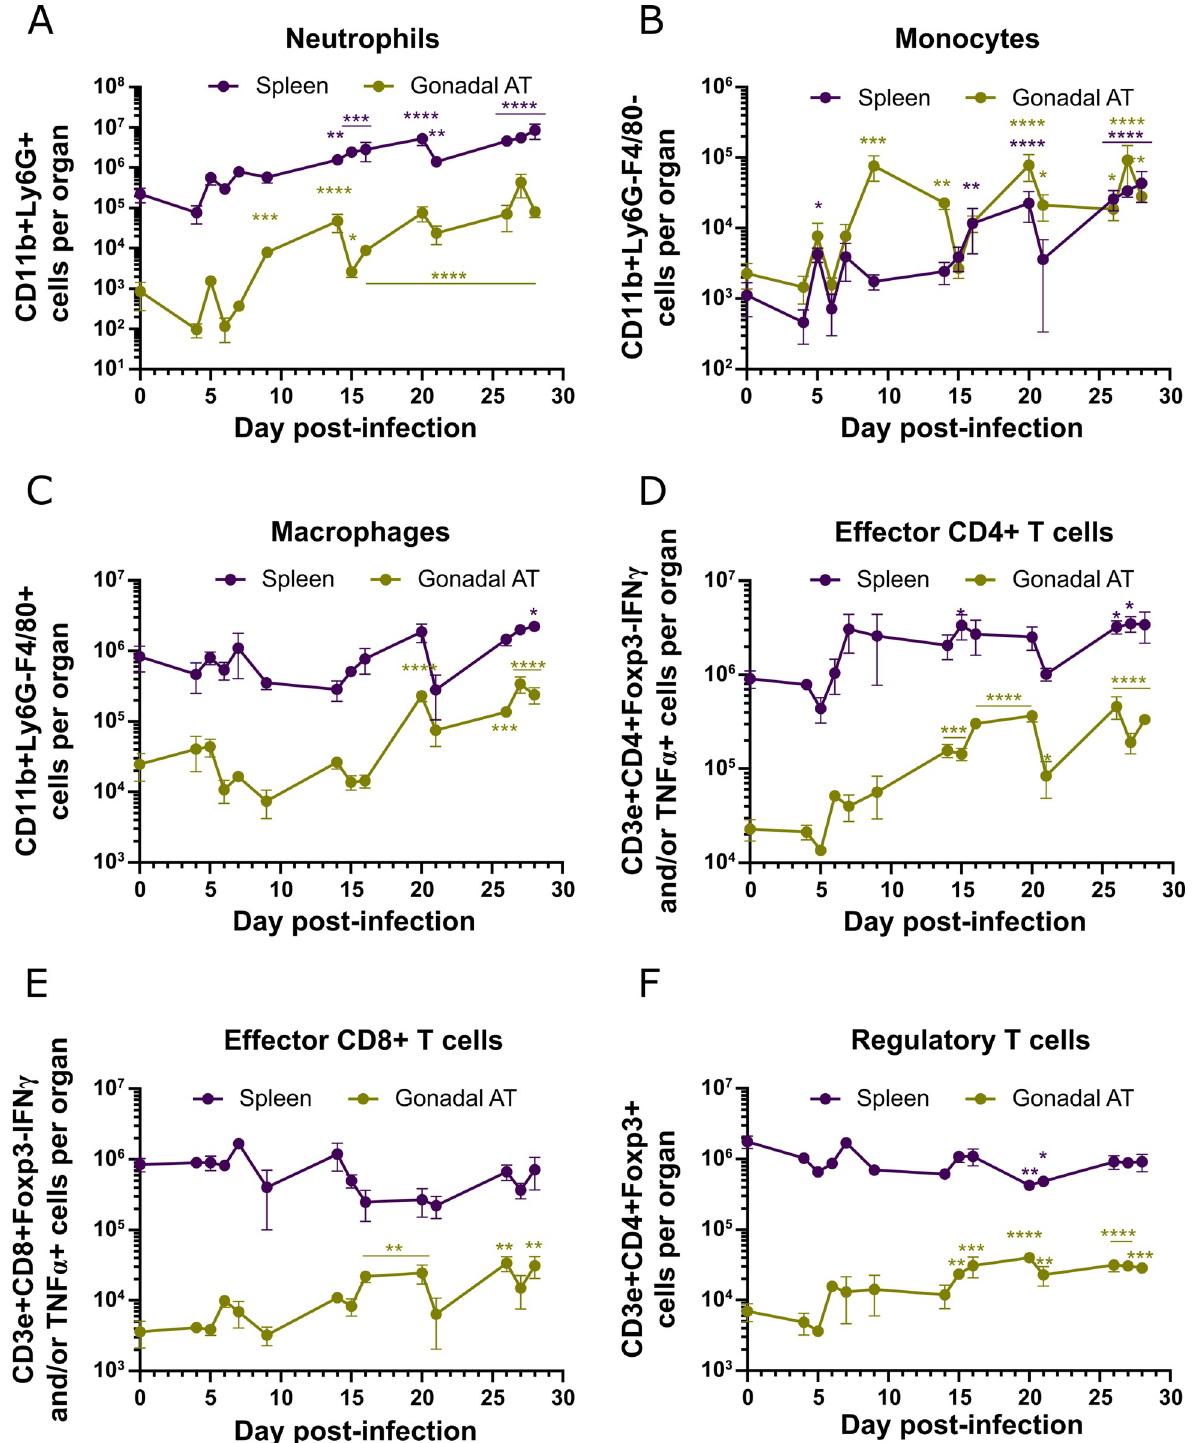
Fig 4. Dynamics of immune cells during infection. (A-F) Number of (A) neutrophils, (B) monocytes, (C) macrophages, (D) effector CD4+ T cells, (E) effector CD8+ T cells and (F) regulatory T cells in the spleen and gonadal AT. Error bars represent the SEM (n = 2–6 mice per group). Statistical analysis was performed with a two-way ANOVA using Sidak’s test for multiple comparisons. � refers to statistical differences within the groups in each time-point and the non-infected group. � , P < 0.05; �� , P < 0.01; ��� , P < 0.001; ���� , P < 0.0001.